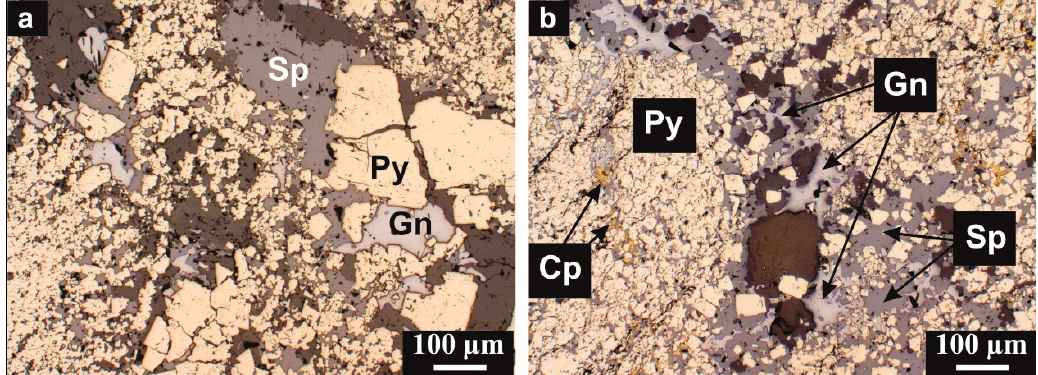
Figure 2. Photomicrographs (plane-polarized reflected light) of representative samples from massive sulphide deposits of the BMC. ( a ) A massive sulphide sample containing intergrowth of galena (Gn) with sphalerite (Sp). Sample is from drill hole 62-55-115 @ 35.2 m (Caribou deposit). ( b ) A bedded sulphide sample containing masses of sphalerite, showing intergrowth with pyrite (Py) and galena. Sample is from drill hole 94-DL-32 @ 402 m (Key Anacon East zone deposit).